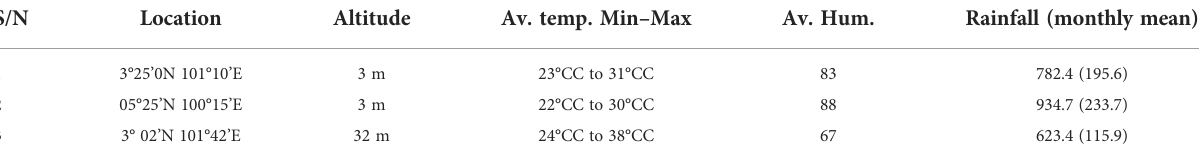
TABLE 1 Weather information of the research